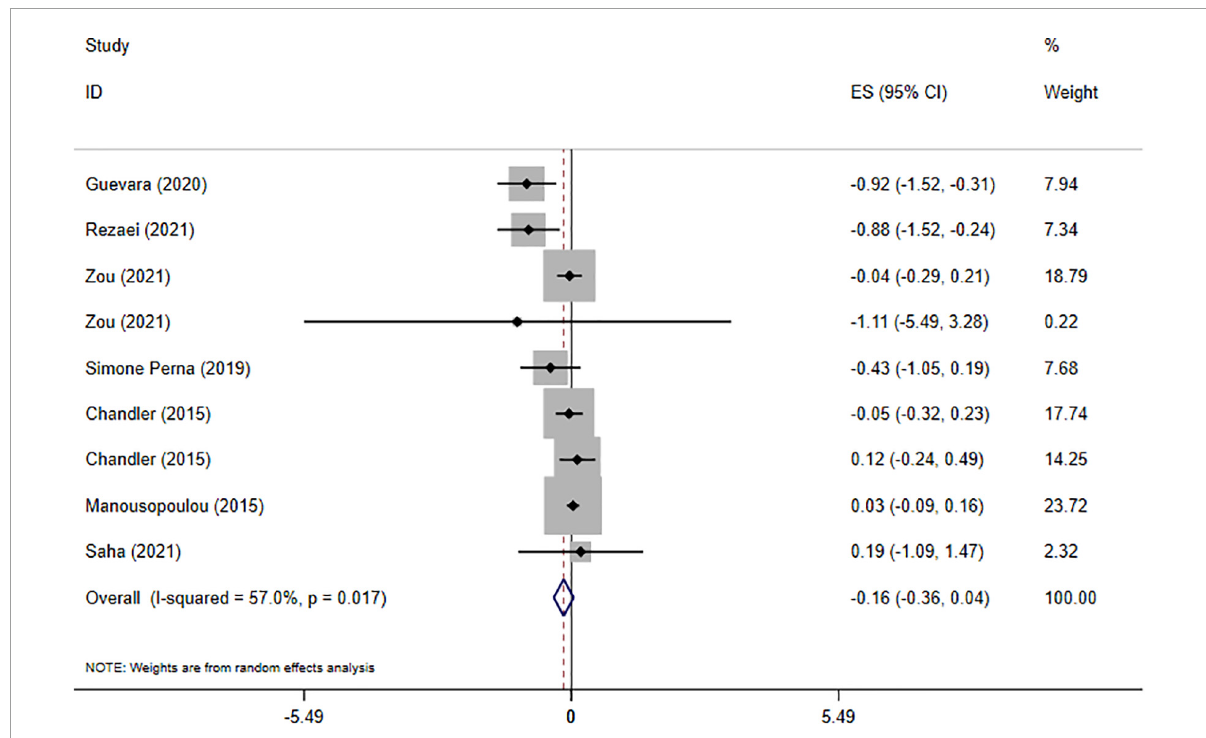
FIGURE2 The effects of vitamin D supplementation on body weight are depicted in a forest plot with mean differences and 95 percent confidence intervals (CIs).